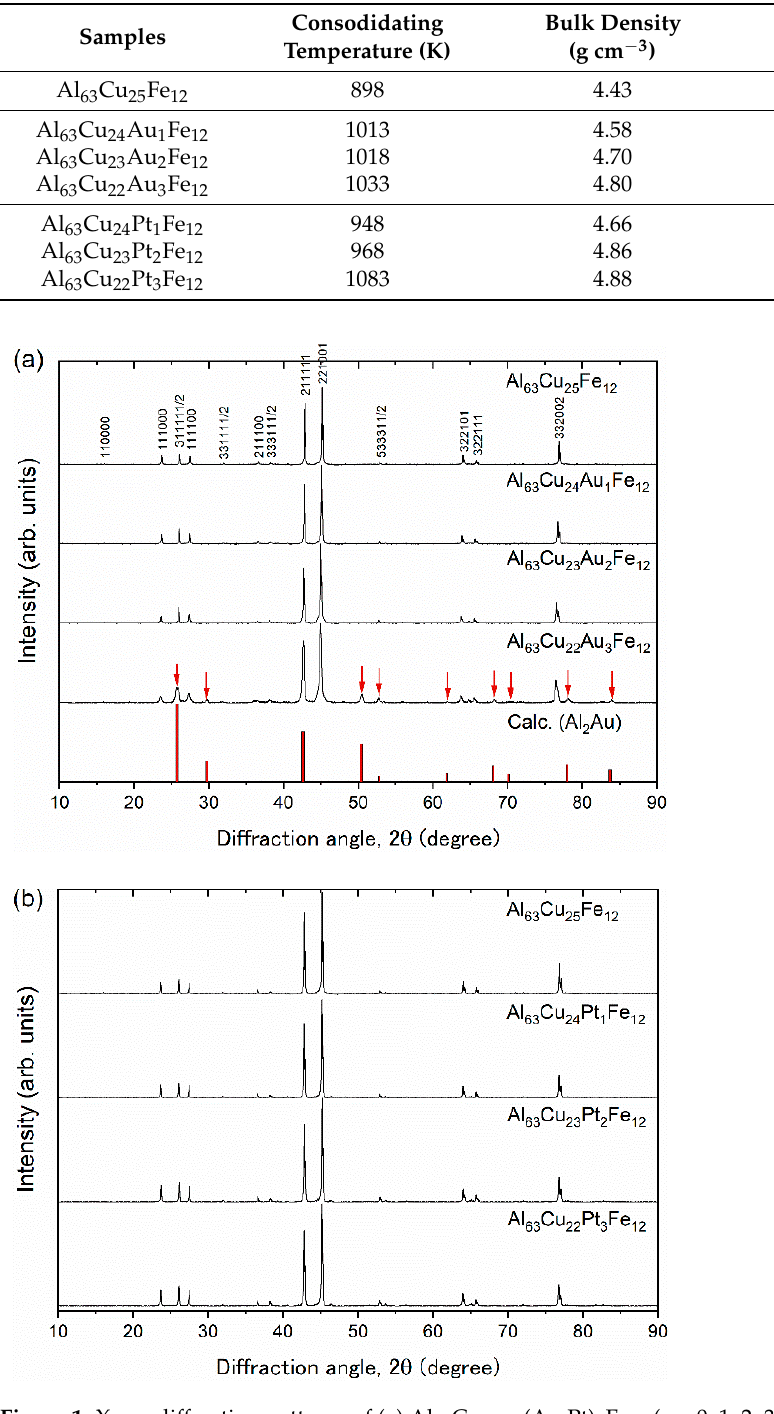
Figure 1. X-ray diffraction patterns of ( a ) Al 63 Cu 25 − x (Au,Pt) x Fe 12 ( x = 0, 1, 2, 3), together with peak indices and calculated peak positions of Al 2 Au, and ( b ) Al 63 Cu 25 − x Pt x Fe 12 ( x = 0, 1, 2, 3). Arrows indicate peaks of excess phase of Al 2 Au.